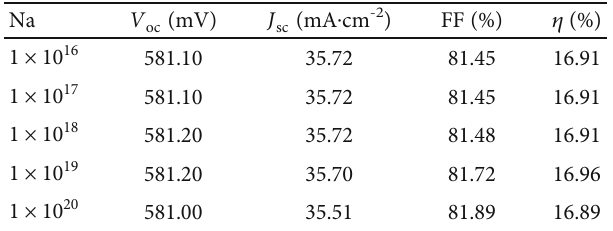
Table 3: Photovoltaic characteristics of the MoO with di ff erent concentrations of the negative charge centers.